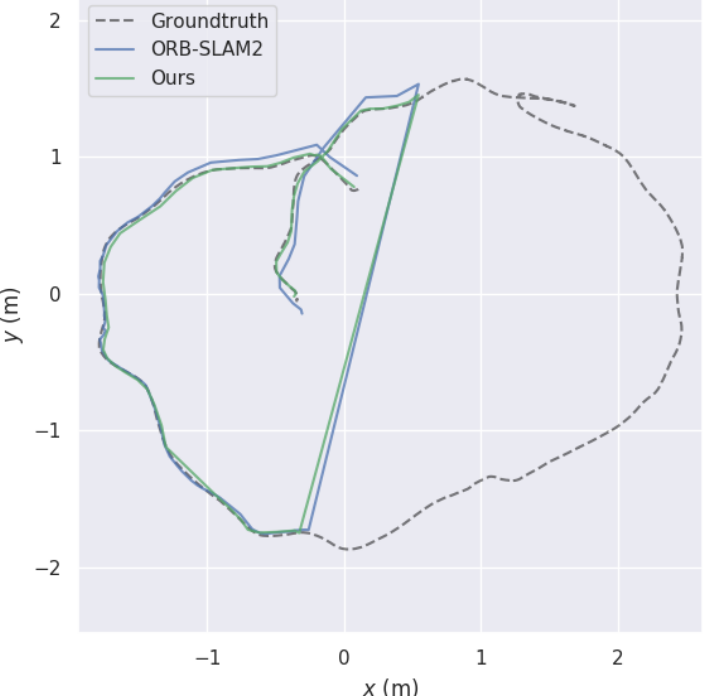
Figure 7. The comparison of the trajectories for the ground truth, ORB-SLAM2, and our method on dataset